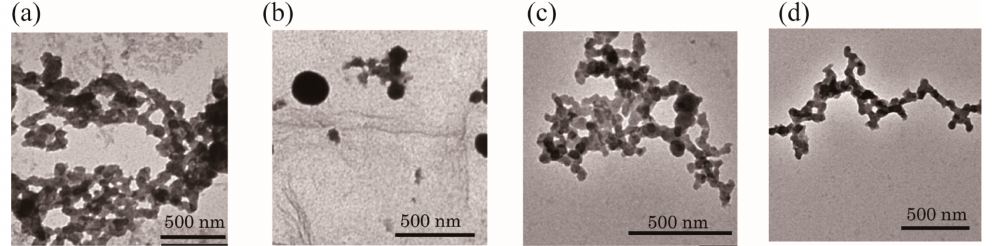
Figure 2. TEM images of the samples after incubation with Ca 2+ for 3 h with ( a ) MYC alone; ( b ) MYC and calmyc; ( c ) MYC, calmyc, and calpain I, and after incubation with Ca 2+ for 24 h with MYC, calmyc, and calpain I ( d ). The TEM samples were stained with phosphotungstic acid.